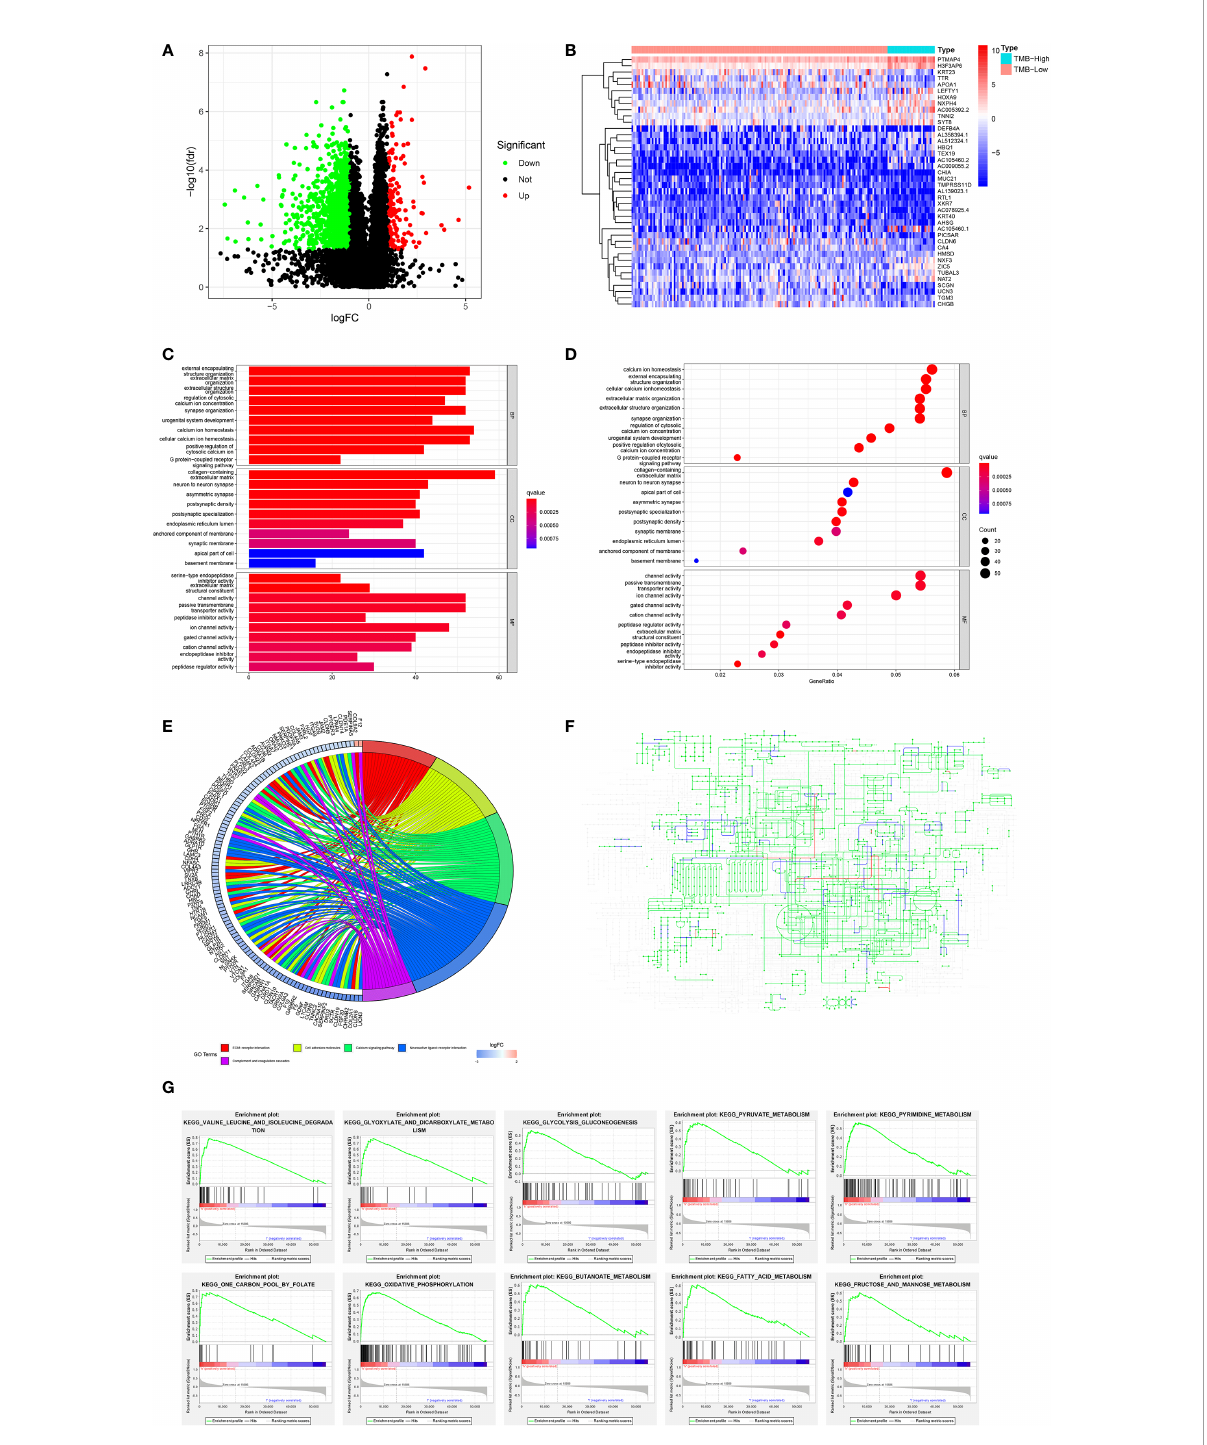
FIGURE 5 Variation of genes according to TMB status and function analysis in the TCGA cohort. (A) Volcano map of DEGs related to TMB status. (B) Heatmap of the top 40 DEGs. (C, D) GO and (E) KEGG analyses of DEGs. (F) The upregulated (red) and downregulated (blue) pathways in the KEGG metabolic pathway map of DEGs. (G) GESA analysis regarding metabolic